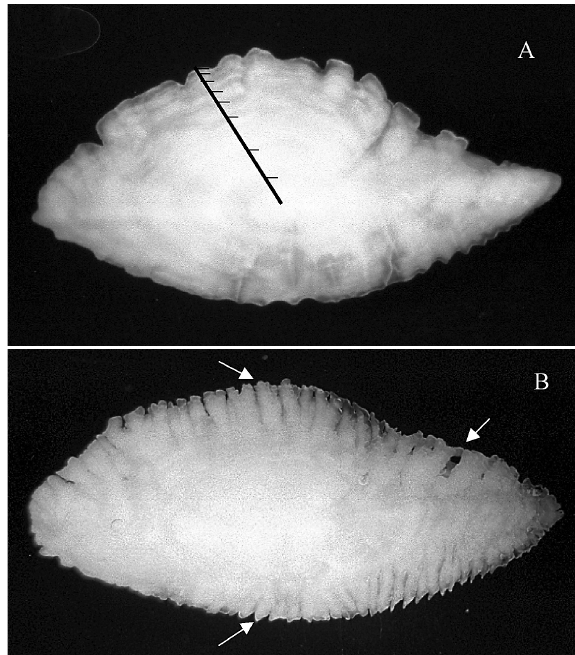
F IG . 2. – (A) Pontinus kuhlii otolith with 8 years assigned. The read- ing line shows the most common path used to identify annual rings. (B) Pontinus kuhlii otolith showing (arrows) edge